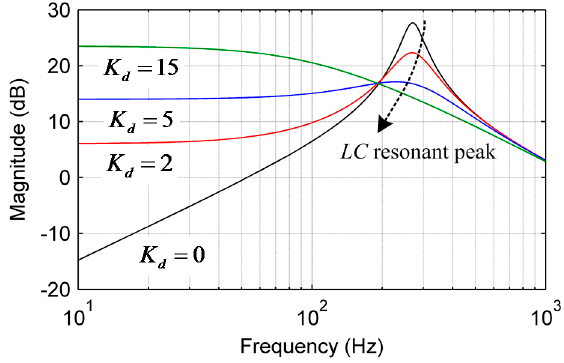
Figure 4. Comparison of the output impedance under different K d .